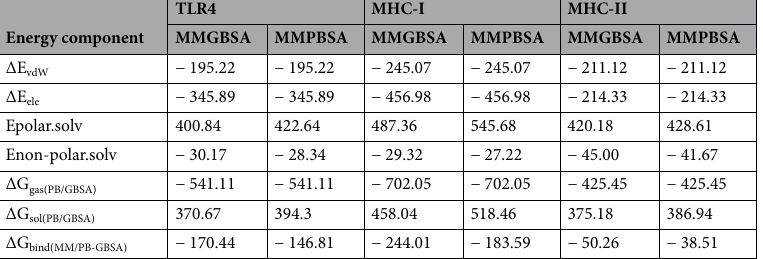
Energy component